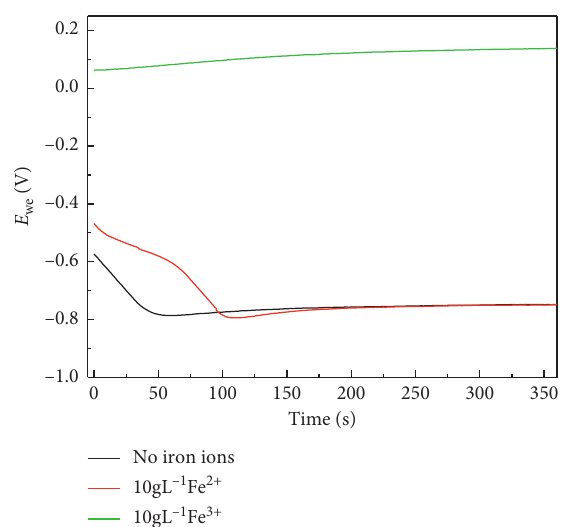
Figure 12: Corrosion potential in 300g L − 1 H